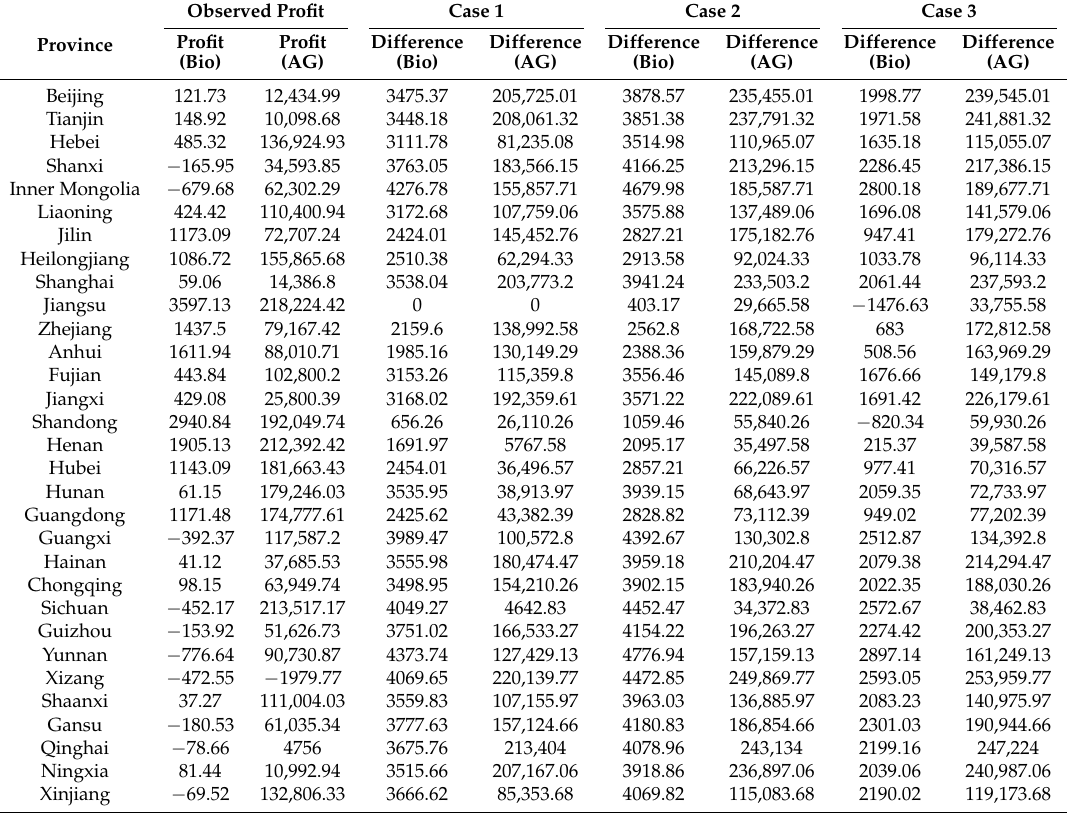
Table 4. Profit gaps between the observed profit and maximum profit for the two industries in three cases of property right imposition across provinces (million RMB).